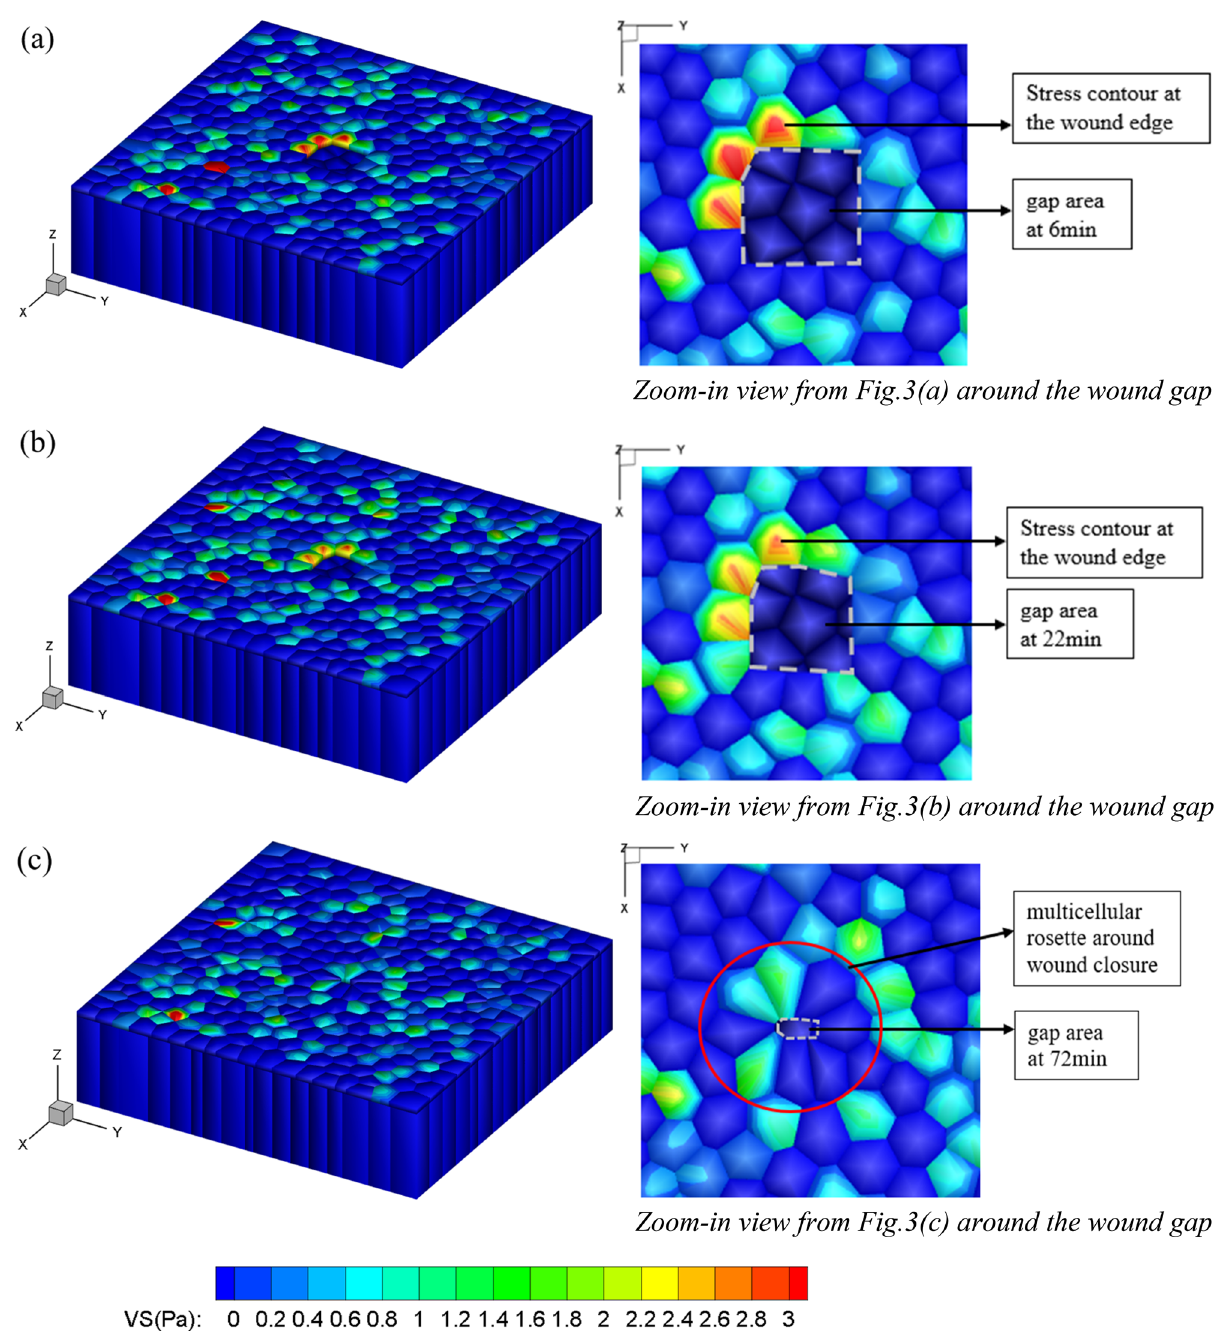
Figure 3. Snapshots of von-Mises stress distribution of 3D epithelial wound closure model (left) and their top- down zoom-in view of the wound area (right) during wound closure process: ( a ) t = 6 min; ( b ) t = 22 min; ( c ) t = 72 min. The color contour shows the stress distribution and its change with time during the wound closure